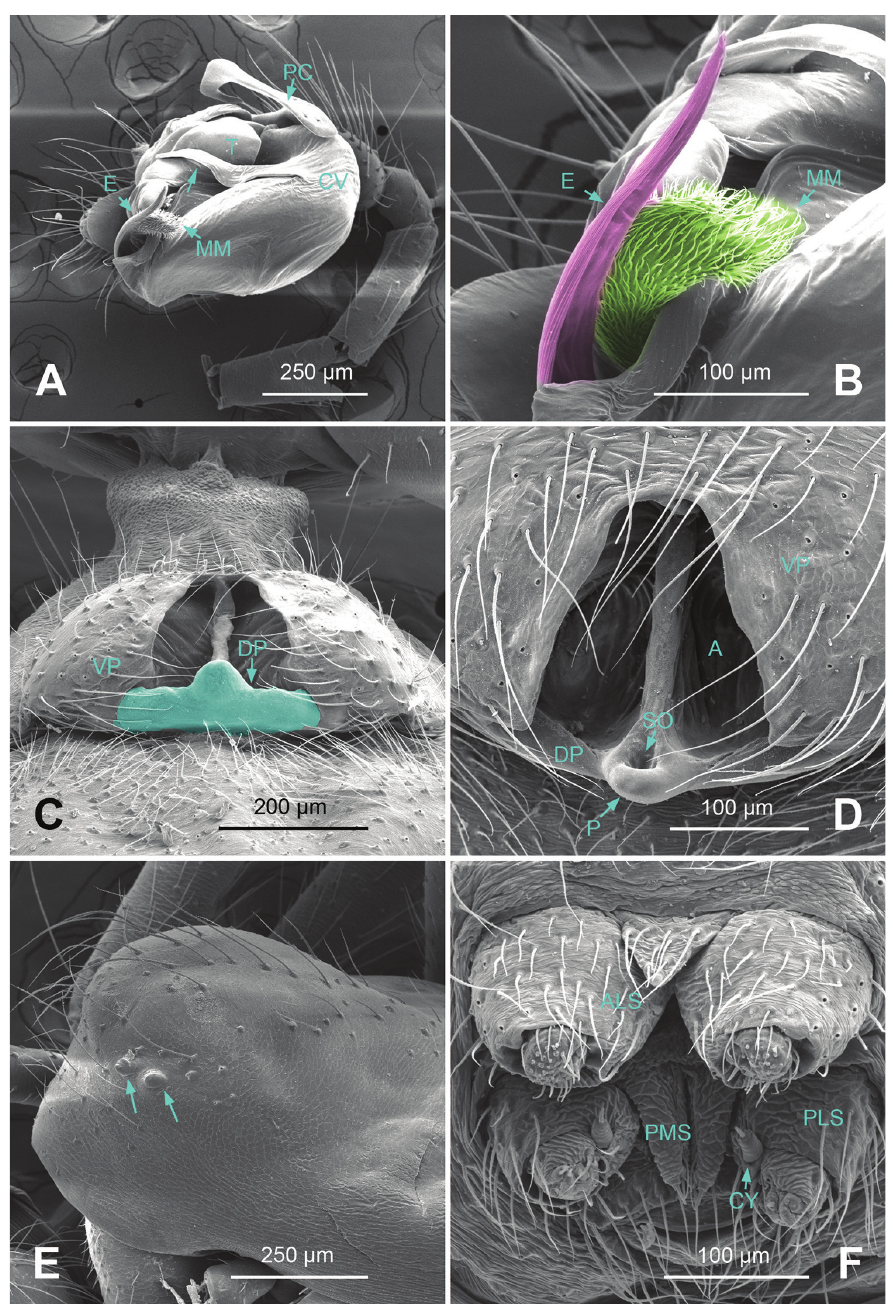
Figure 4. Callosa ciliata sp. n., SEM of a male paratype and a female paratype. A Palp of male paratype, ventral view B Detail showing embolus and embolic membrane of palp C Epigyne of female paratype, ventral view D Detail showing parmula of epigyne E Anterior lateral eye and posterior lateral eye of male paratype F Spinnerets of female